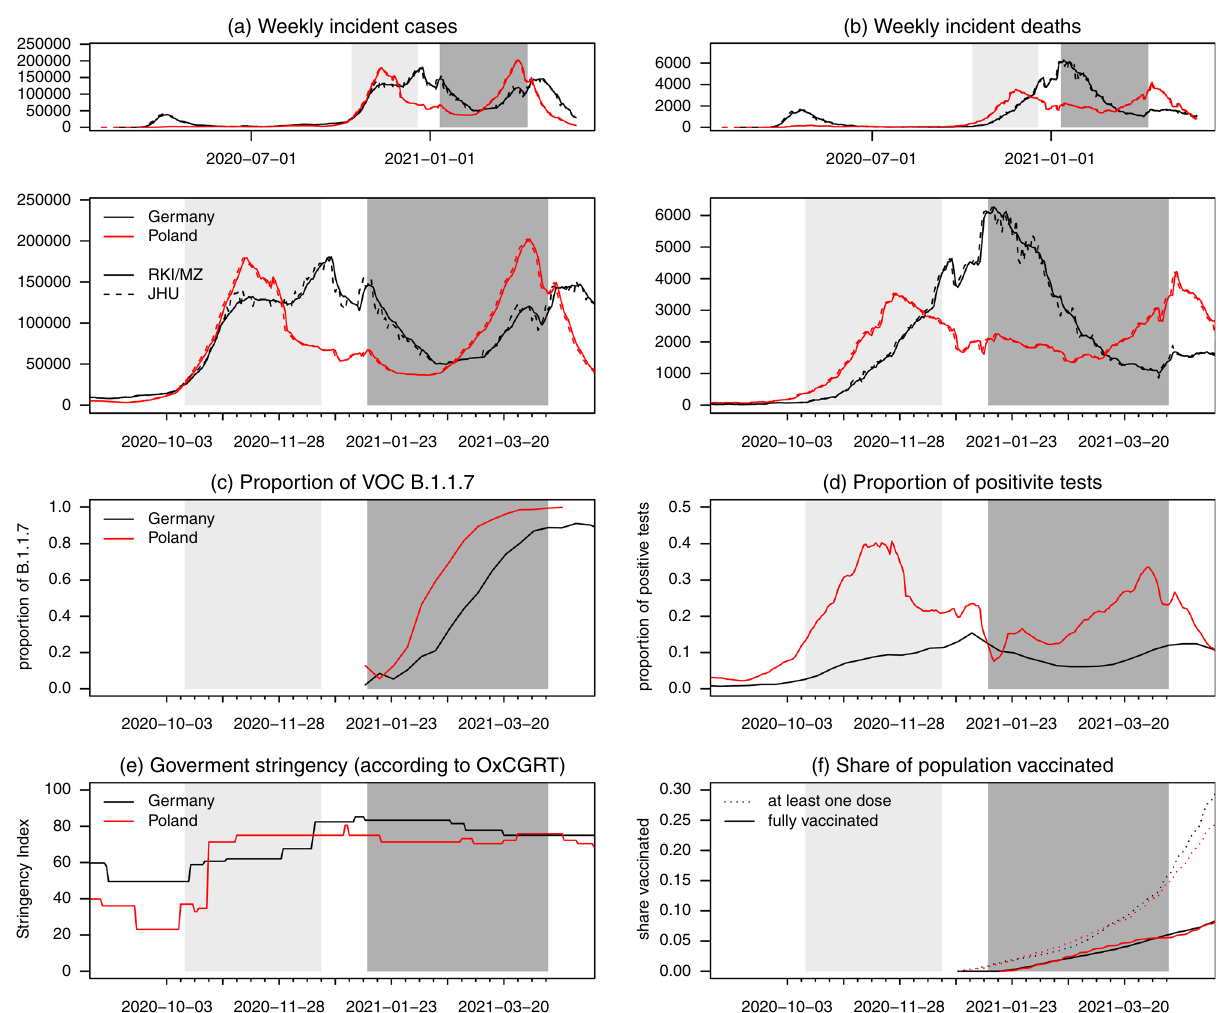
Fig. 1 Overview of relevant epidemiological time series. Reported cases ( a ) and deaths ( b ) per seven days in Germany (black) and Poland (red) according to Robert Koch Institute, the Polish Ministry of Health (MZ; solid lines), and Johns Hopkins CSSE (dashed). Additional panels show c the share of cases due to the B.1.1.7 (Alpha) variant, d the proportion of all performed PCR tests which turned out positive, e the overall level of non-pharmaceutical interventions as measured by the Oxford Coronavirus Government Response Tracker (OxCGRT) Stringency Index, and f the population shares having received at least one vaccination dose (dotted) and complete vaccination (solid). The dark gray area indicates the period addressed in the present manuscript, and the light gray area is the one from Bracher et al. 16